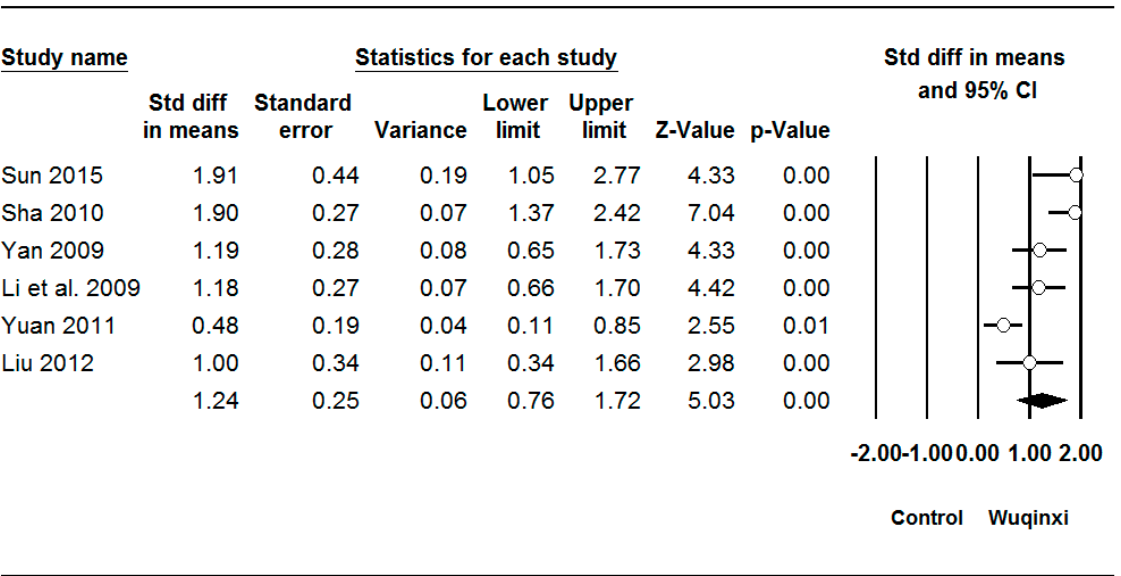
Figure 6. Effect of Wuqinxi on low-density lipoprotein cholesterol. Effect size (95% CI) of each study is denoted by circle (black line). The mid-point of the circle represents the point effect estimate, meaning effect estimate for each study. The area of the circle represents the weight given to the study. The diamond below the studies represents the overall effect.